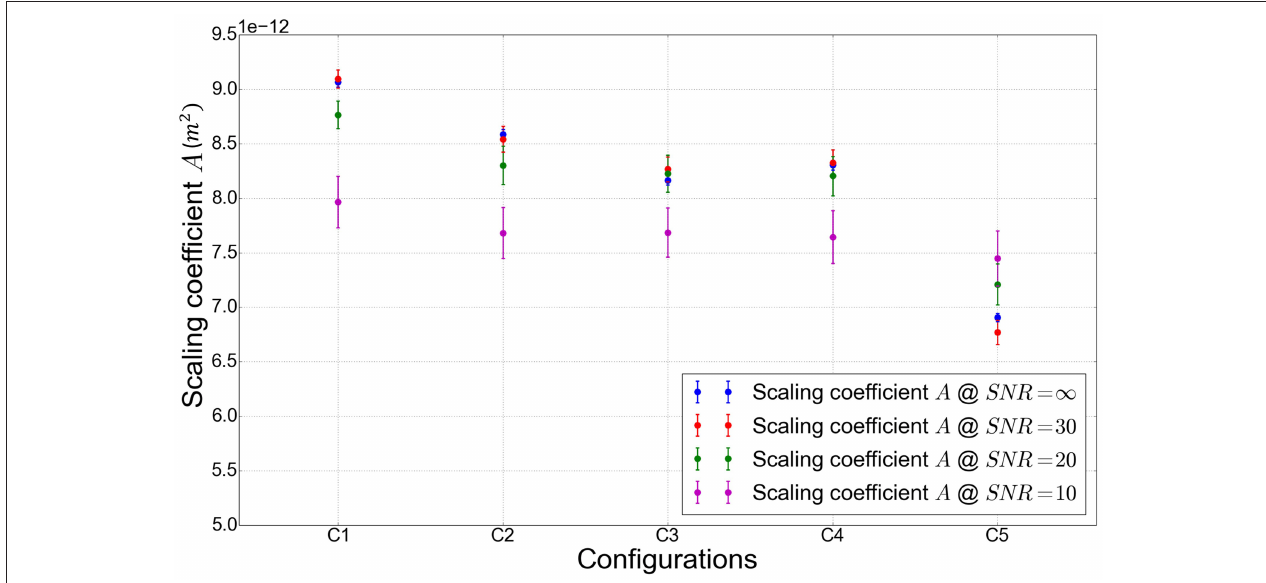
FIGURE 9 | Value of the scaling coefficient A in m 2 for geometric configurations with increasing structural disorder. The simulation are performed in configurations C1–C5, whose design parameters are summarized in Table 2